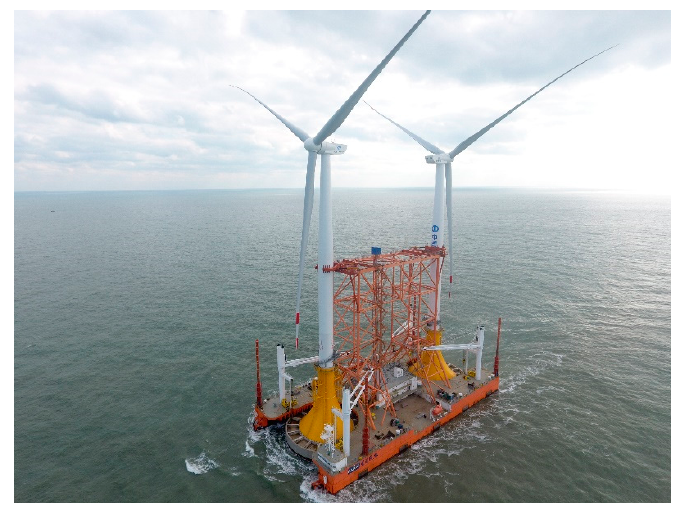
Figure 1. Composite bucket foundation for offshore wind turbines (photo was taken by the author).